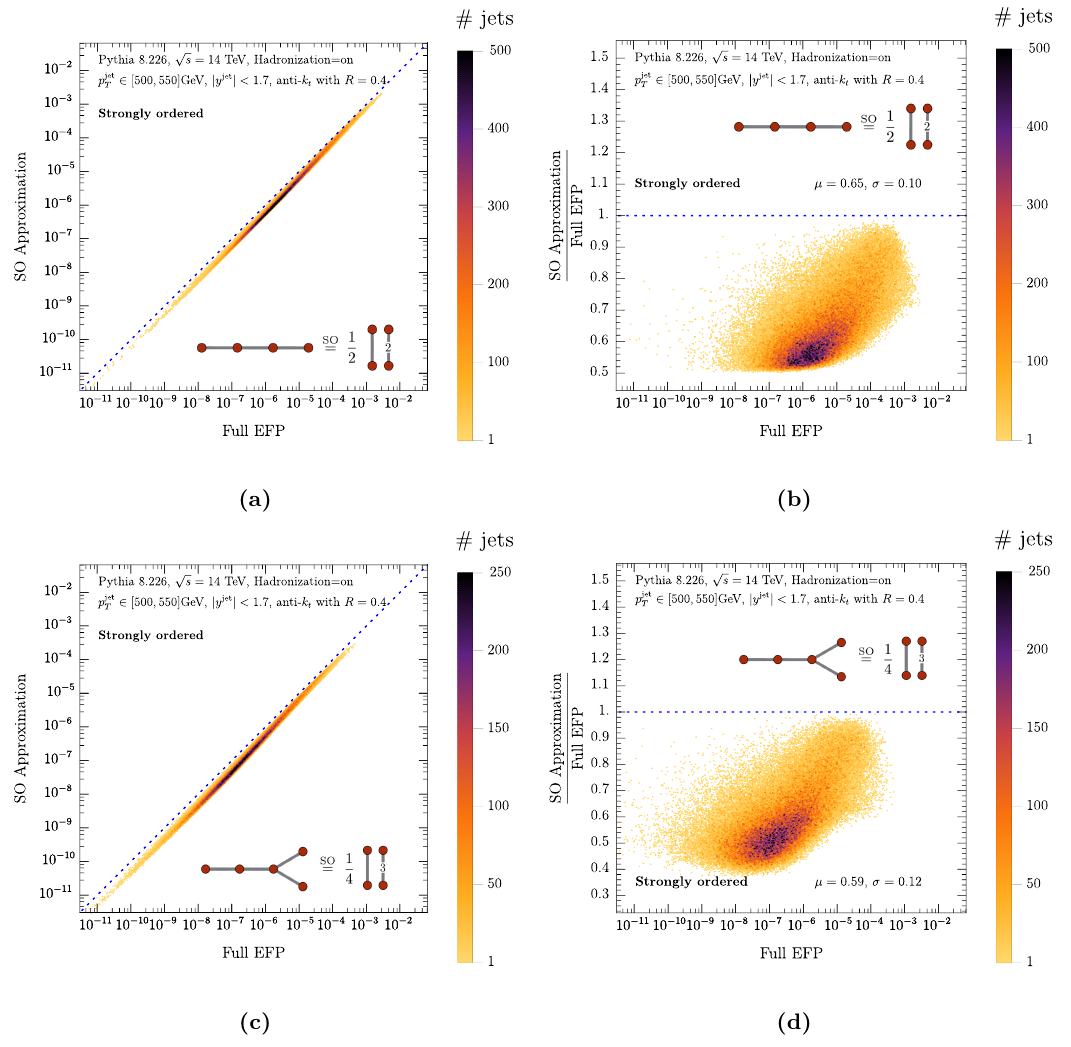
Figure 4. Testing the strongly-ordered relationship for the 4-dot EFP in eq. (2.8) (top row) and the crocodile EFP in eq. (2.10) (bottom row). Results are shown as a correlation plot (left column) and ratio (right column). The average µ and standard deviation σ of the ratio is also